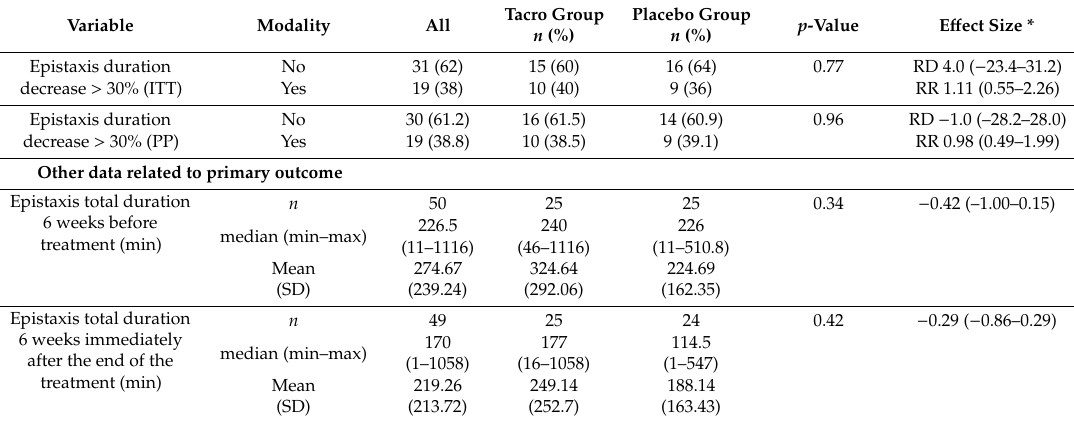
Table 2. Main outcome ( n = 50) analysis: E ffi cacy of tacrolimus ointment on mean epistaxis duration six weeks before and after